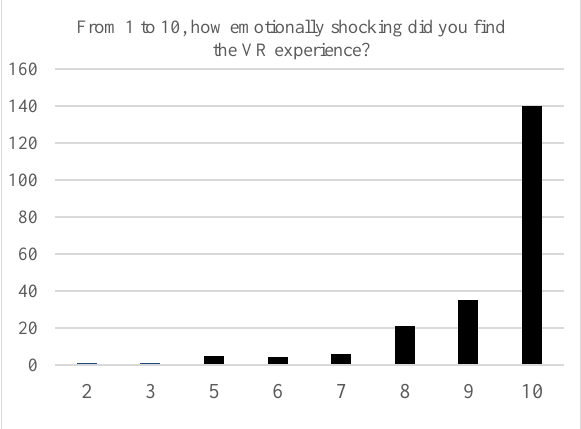
Table 1. VR user Satisfaction Survey, linear scale.